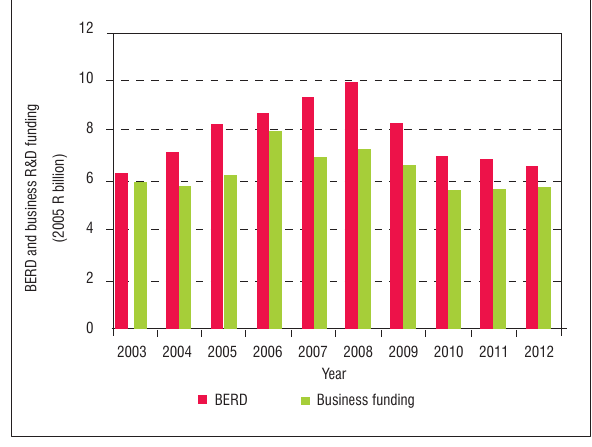
Figure 7: BERD and business R&D funding in constant 2005 R billion (2003 to 2012).